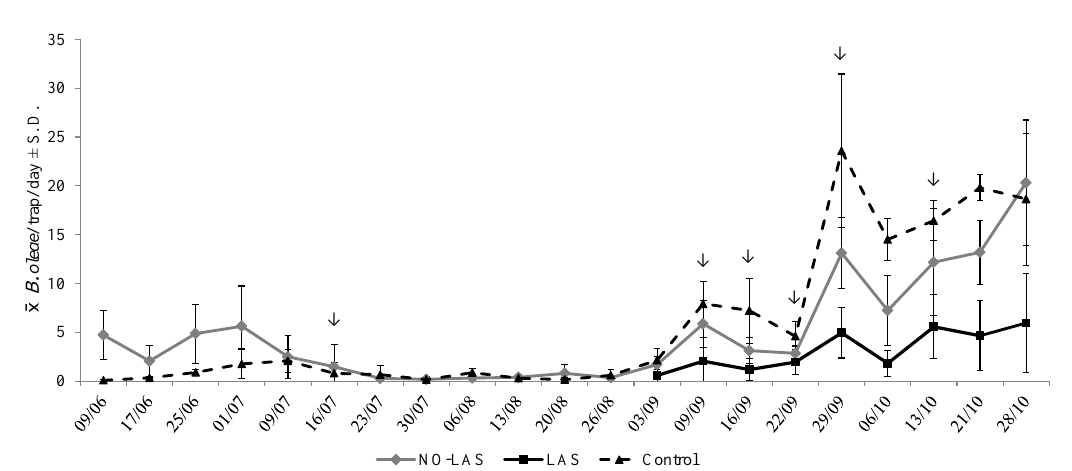
Figure 10. Average of FTD captures ± S.D. with Rimi ® traps in NO-LAS, LAS, and control plots. Arrows indicate the week of spraying.